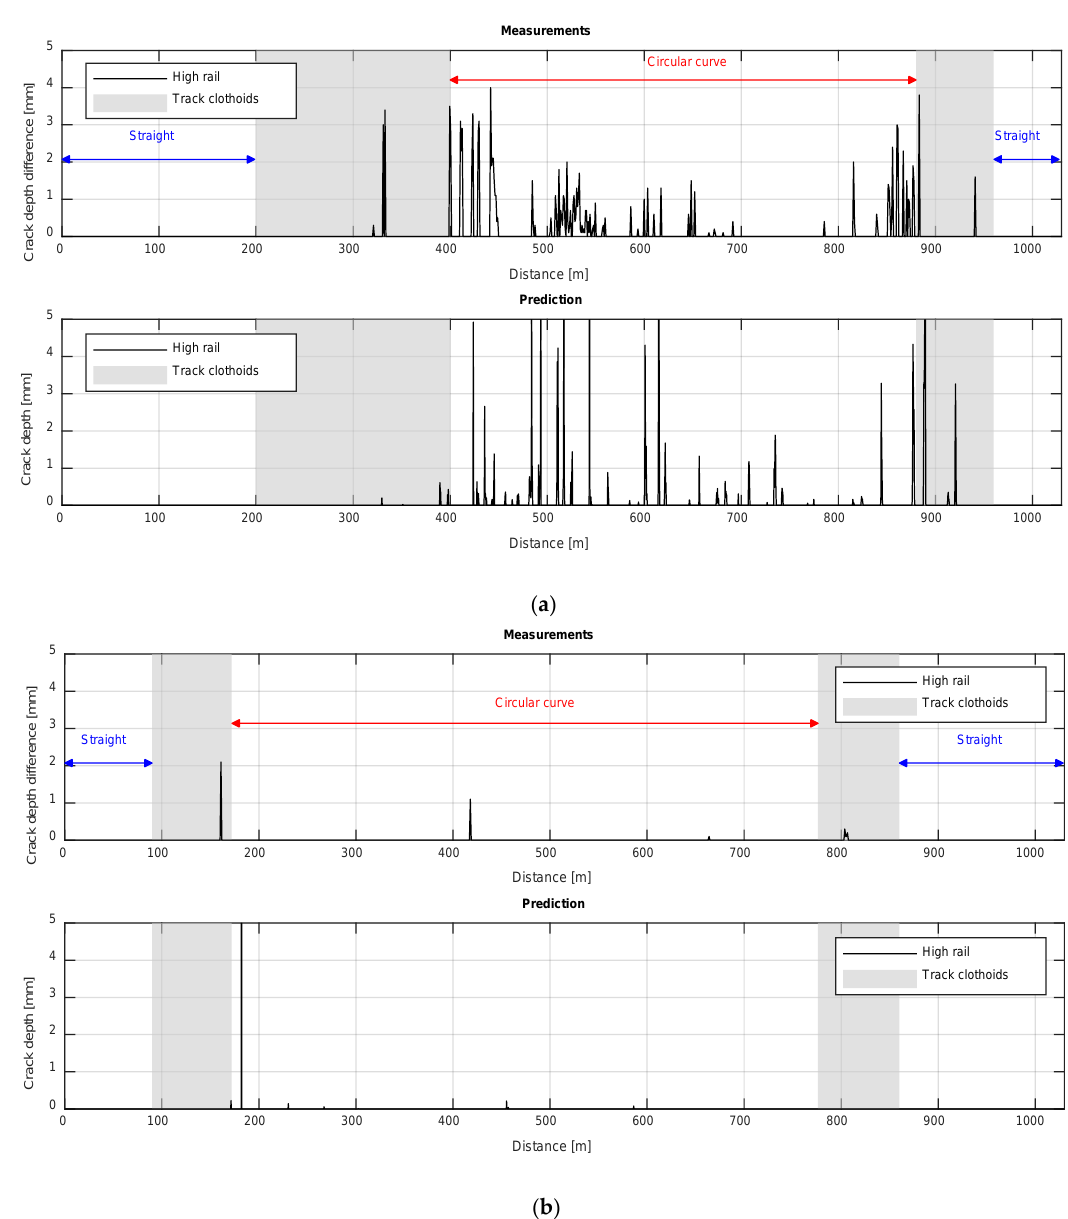
Figure 12. Location comparison between predicted and measured cracks for 4.752 MTn: ( a ) Section 1; ( b ) Section 2.